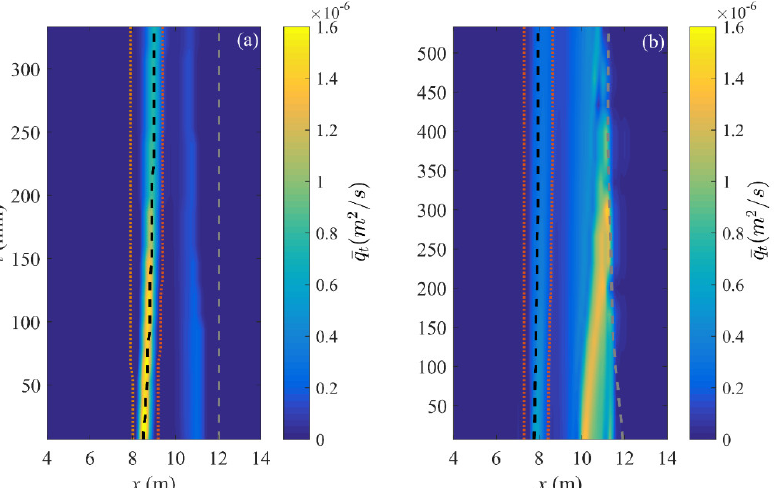
Figure 10. Spatiotemporal evolution of period-averaged total sediment transport rate in case A1_2 ( a ) and E1_1 ( b ). Black dashed line means the crest of the nourishment and two dotted lines indicate two boundaries. Shoreline position is indicted by the grey dashed line.